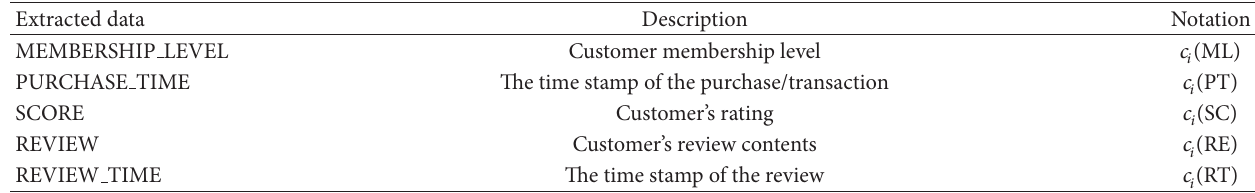
Table 2: Information extracted in an online review 𝑐 𝑖 .